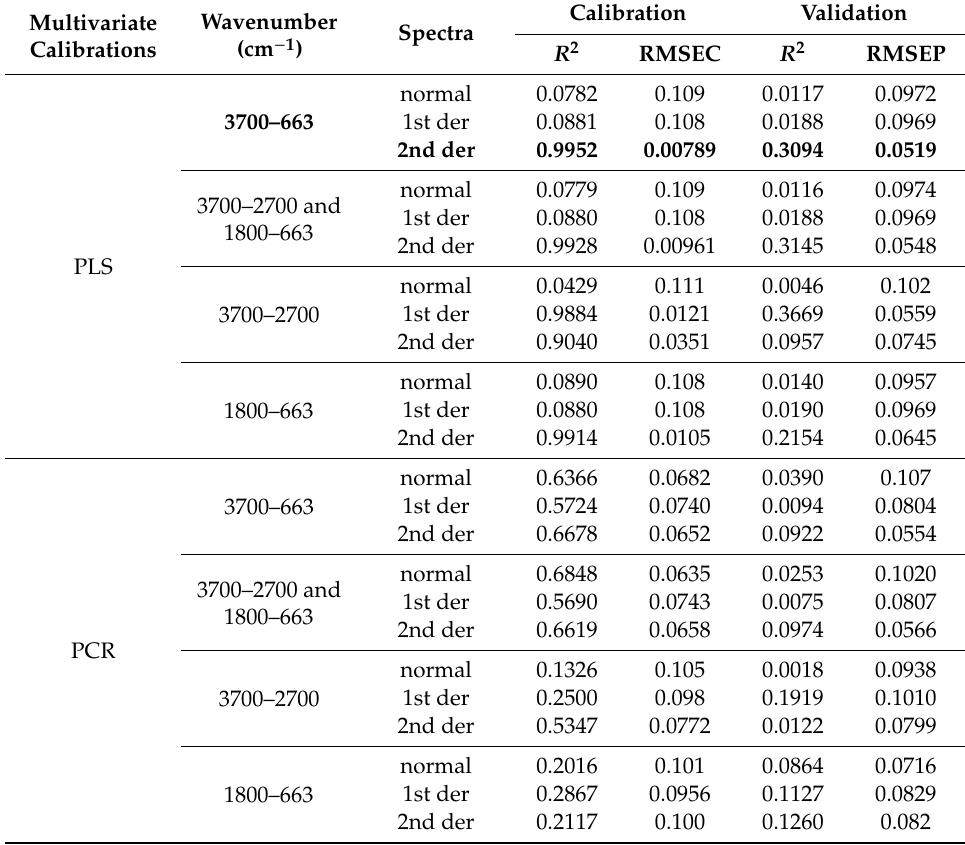
Table 4. The statistical parameters of multivariate calibrations of Principle Component Regression (PCR) and Partial Least Square (PLS) for quantitative analysis of gartanin (GT).